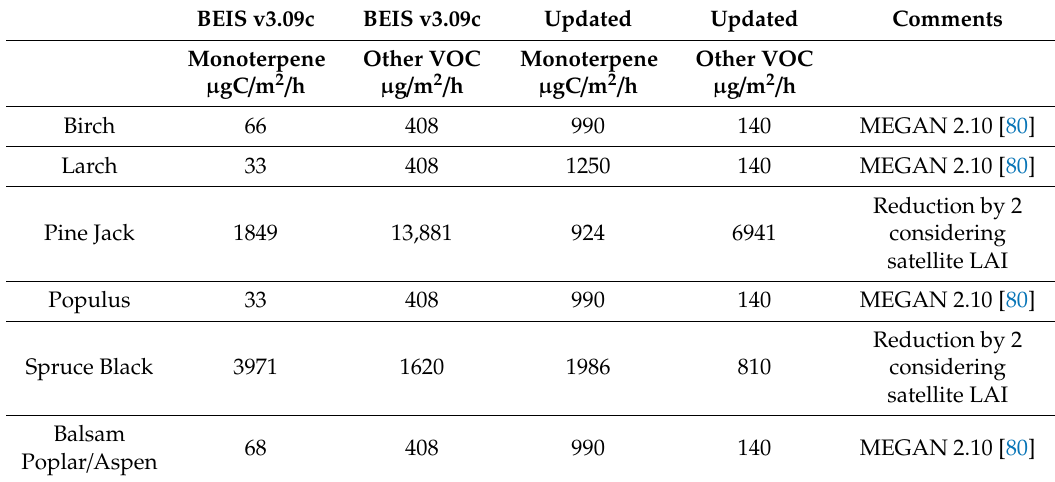
Figure A1. The ratio of the MODIS-derived leaf area index (LAI) to the Biogenic Emission Inventory System (BEIS)-derived LAI for Northern Alberta and Saskatchewan. Table A1. Updates to the Biogenic Emissions Inventory System for the Canadian Boreal